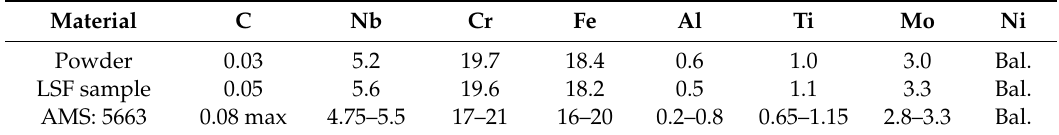
Table 1. Chemical composition of the Inconel 718 superalloy powder and the laser solid forming (LSF) sample (wt.%).